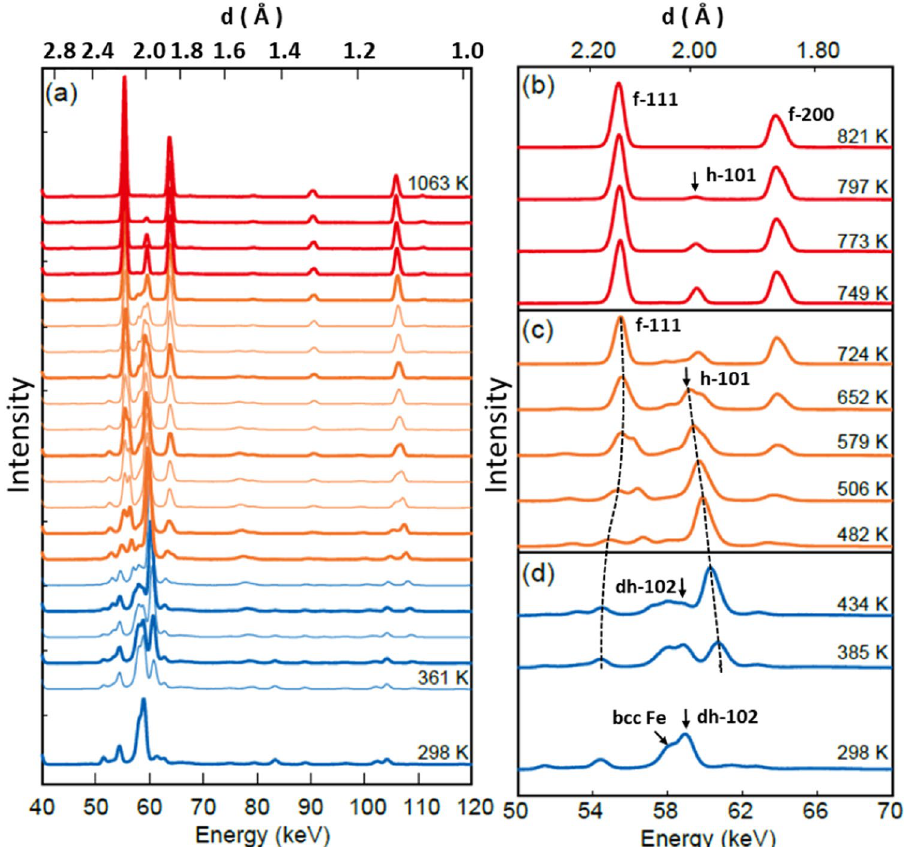
Figure 2. X-ray diffraction profiles collected for iron hydride upon cooling, showing ( a ) overall evolution and ( b ) fcc-dominant, ( c ) hcp-dominant, and ( d ) dhcp-dominant regions; reflection indices are assigned to the major peaks of each structure, where the shifts of the fcc 111 and hcp 101 peaks are indicated by broken lines to guide the